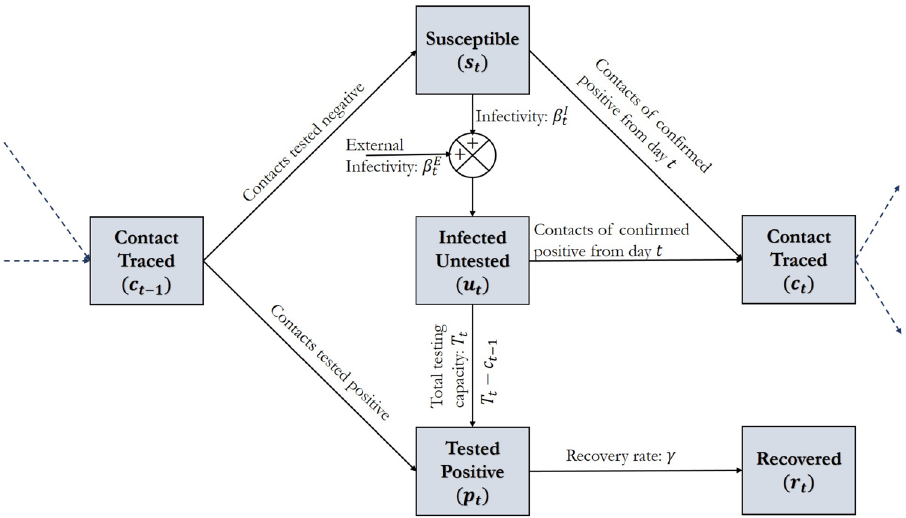
Figure 1. The SUPR Infection Dynamics with Testing and Contact Tracing (where, s t : number of susceptible individuals, u t : number of undetected infected individuals, p t : number of positive infections detected from testing, r t : number of recovered individuals, c t number of contacts traced on date t , T t : total number of tests, β I t : internal infectivity, β E t : external infectivity, and γ : recovery